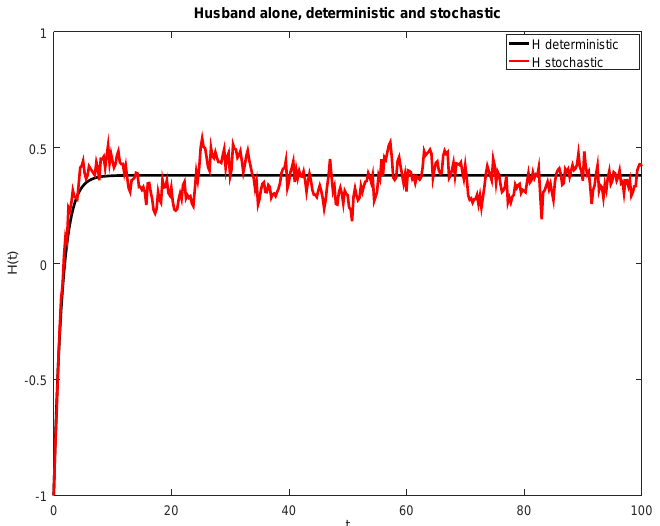
Figure 5. A numerical simulation of the deterministic case and a stochastic realization for a validating husband with no influence from the